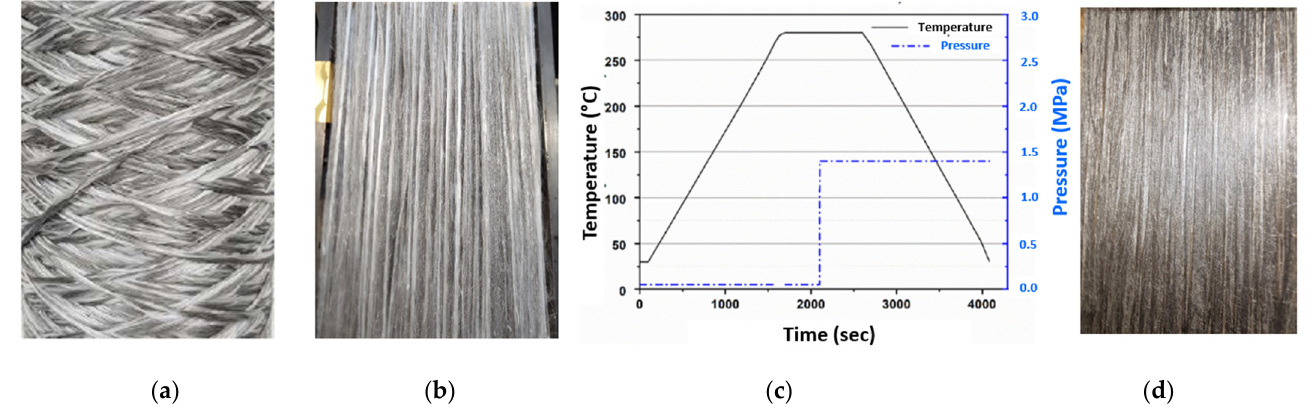
Figure 4. Composite development: ( a ) innovative commingled yarns, ( b ) unidirectional prepreg, ( c ) consolidation cycle and ( d ) fiber–metal hybrid